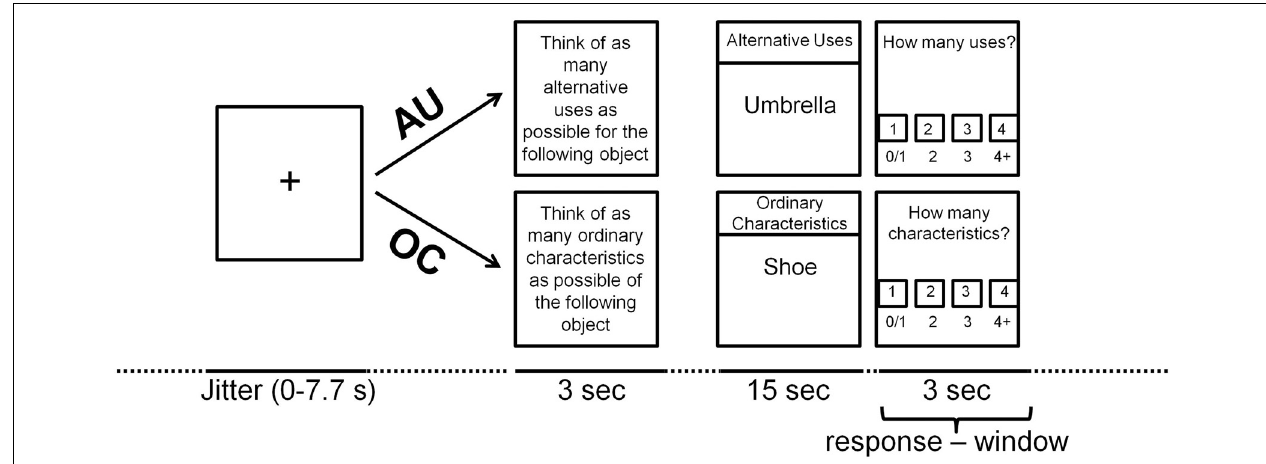
FIGURE 1 | Time-line of the AUT-scanner task trial (see text for